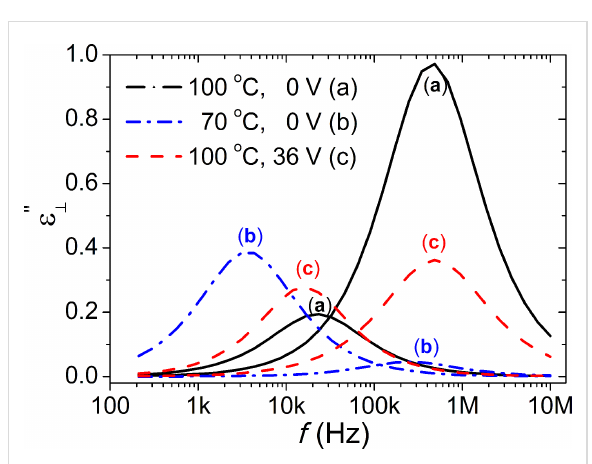
Figure 7: Effect of temperature and bias voltage on the two relaxation processes for BCN66: (a) solid black line 100 °C, 0 V; (b) dash–dot blue line 70 °C, 0 V; and (c) dashed red line 100 °C, 36